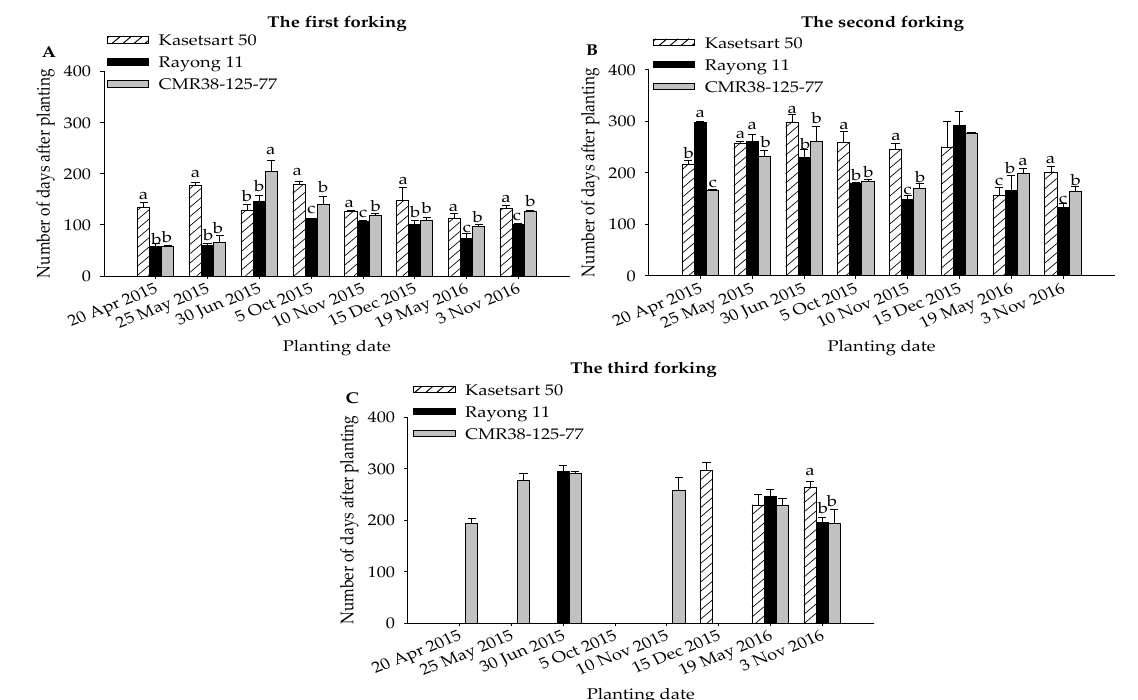
Figure 2. Mean values for the first forking date ( A ), the second forking date ( B ), and the third forking date ( C ) for four cassava genotypes grown on eight planting dates. The same letters (in each planting date) are not significantly different by the Least Significant Difference Test at p ≤ 0.01, except for the second forking date on 19 May 2016 ( p ≤ 0.05). Error bars indicate the standard deviation of the means. The forking dates were observed from ten non-destructive plants for each experimental plot. The forking for Rayong 9 was not detected within 300 days after planting (DAP). The third forking for Kasetsart 50 was not detected within 300 DAP for the April, May, June, October, and November 2015 planting dates. For Rayong 11, the third forking was not detected within 300 DAP for the April,